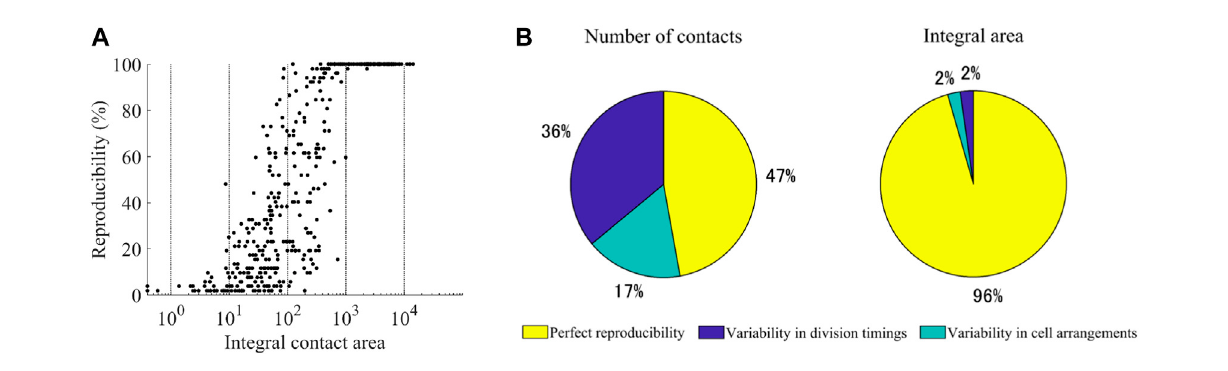
FIGURE 4 Reproducibilityofcell-cellcontacts (A)